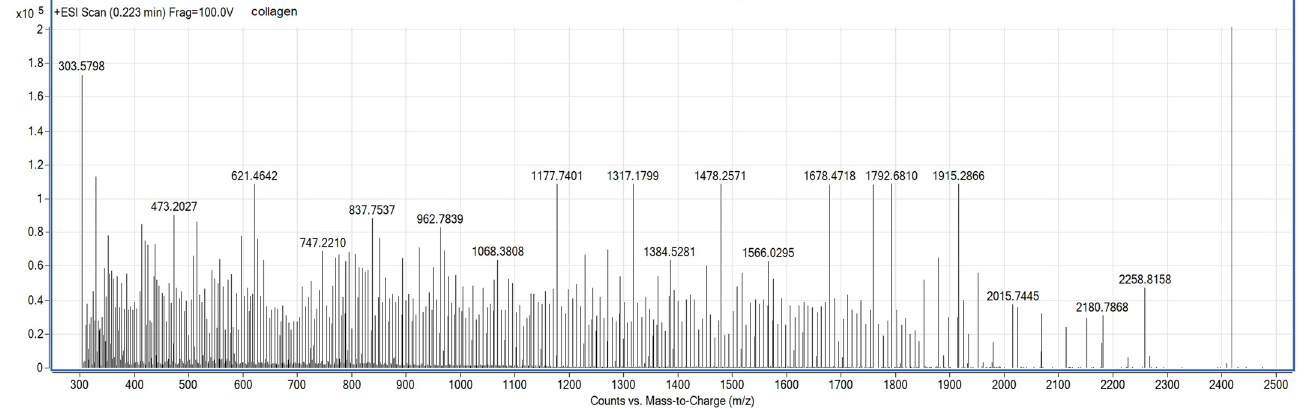
Figure 4. Analysis of collagen